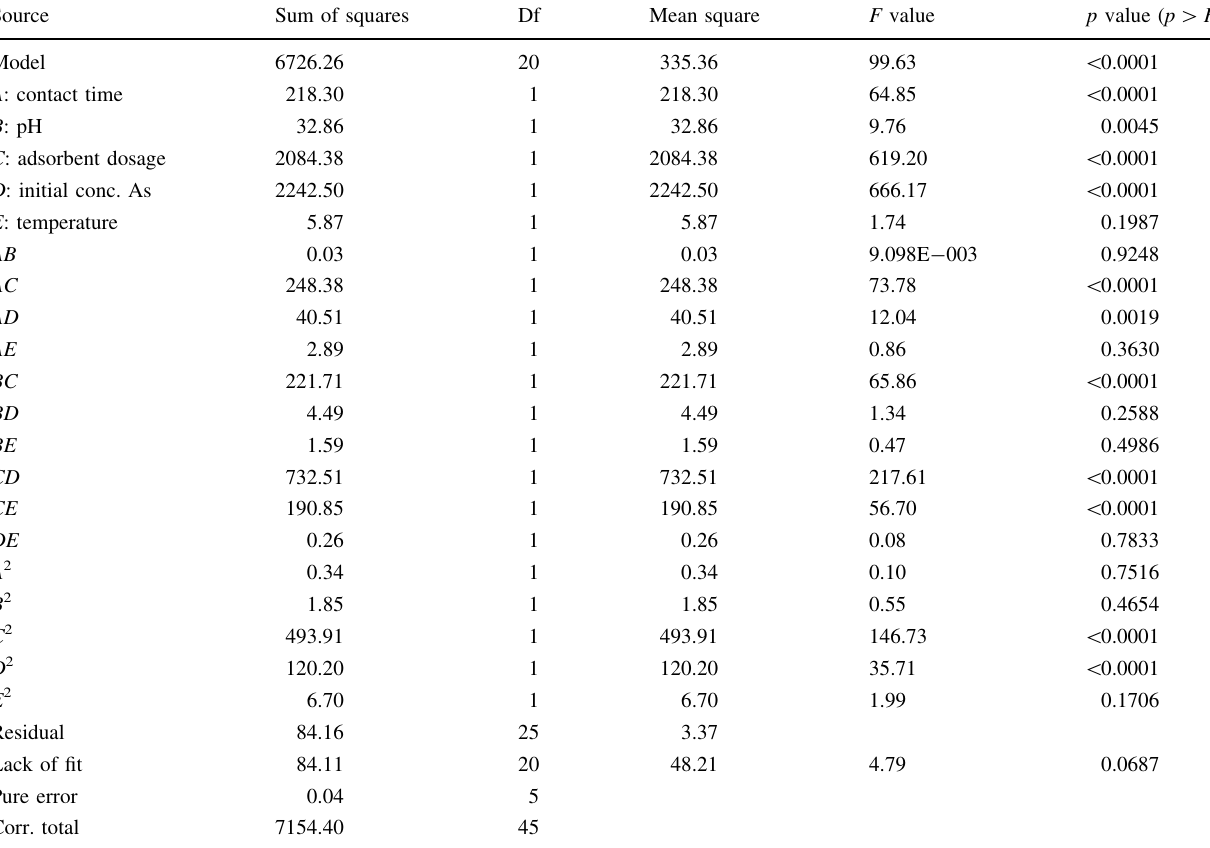
Table 4 ANOVA for response surface quadratic model ( Y